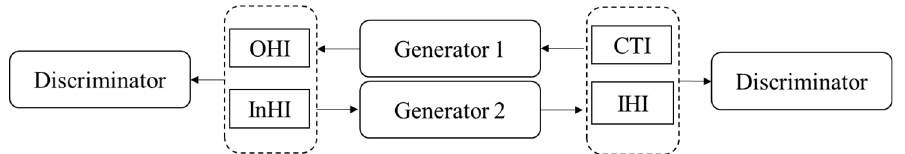
Figure 11. The architecture of CycleGAN. InHI, IHI, OHI, and CTI refer to the input halftone image, the inverse halftone image, the output halftone image, and the continuous-tone image, respectively.